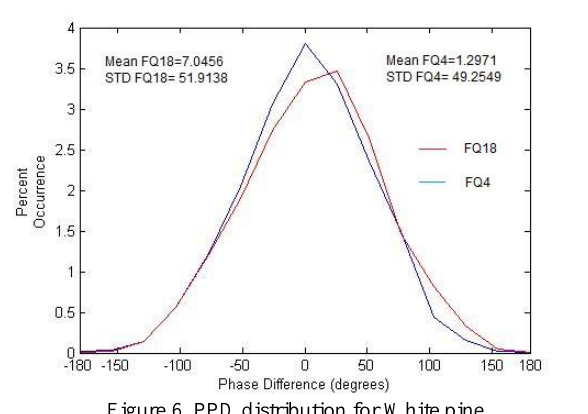
Figure 6. PPD distribution for White pine Jack Pine ranges from 9–22 m in height. It’s a smaller tree that needle-like, twisted, slightly yellowish-green, and 2–4 cm long.